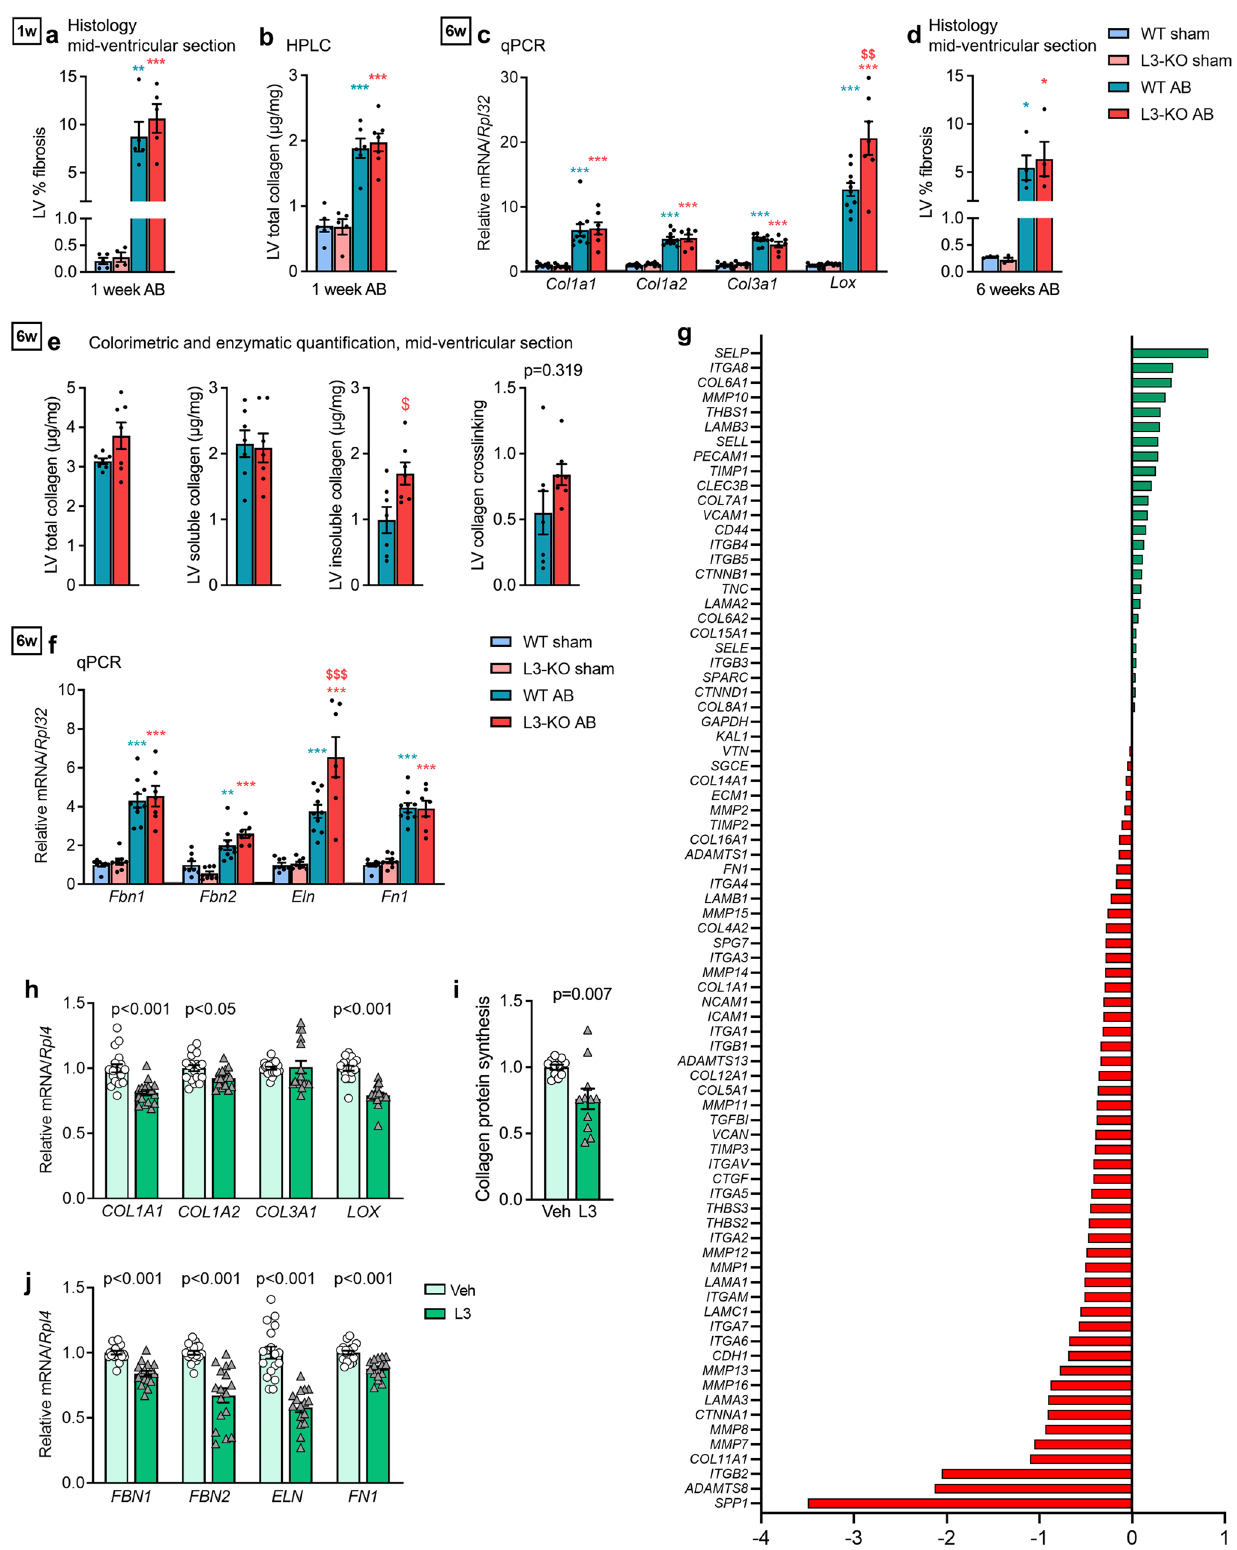
germ-line transmission of the mutant allele, was retained and crossed into the C57BL/6J strain. WT and L3-KO ear biopsies were genotyped using the WT for- ward primer: 5 ’ -GGCTTCCTGGACAGGATCC-3 ’ , or the L3-KO forward primer: 5 ’ -CCCATGGCTTCCTGGATCC-3 ’ , and a common reverse primer: 5 ’ - GGGTGTGTTAACAGTGAATCC-3 ’ , in two separate PCR reactions, with resulting PCR products of 428bp (Fig. S3a). Ablated expression of Adamtsl3 in L3-KO hearts was con fi rmed by RNA-seq (Fig. S3b) and RT-qPCR (Fig. S3c) of LV